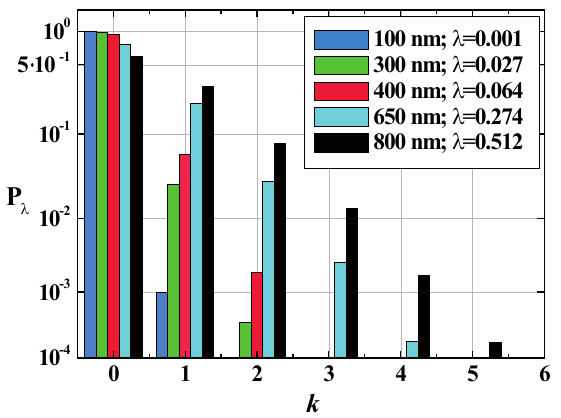
Fig. 5. Probability P λ for k = 0 , 1 , 2 , 3 , 4 , 5 INA protein complexes per particle/droplet (Poisson distributed) for different average num- bers of INA protein complexes λ .